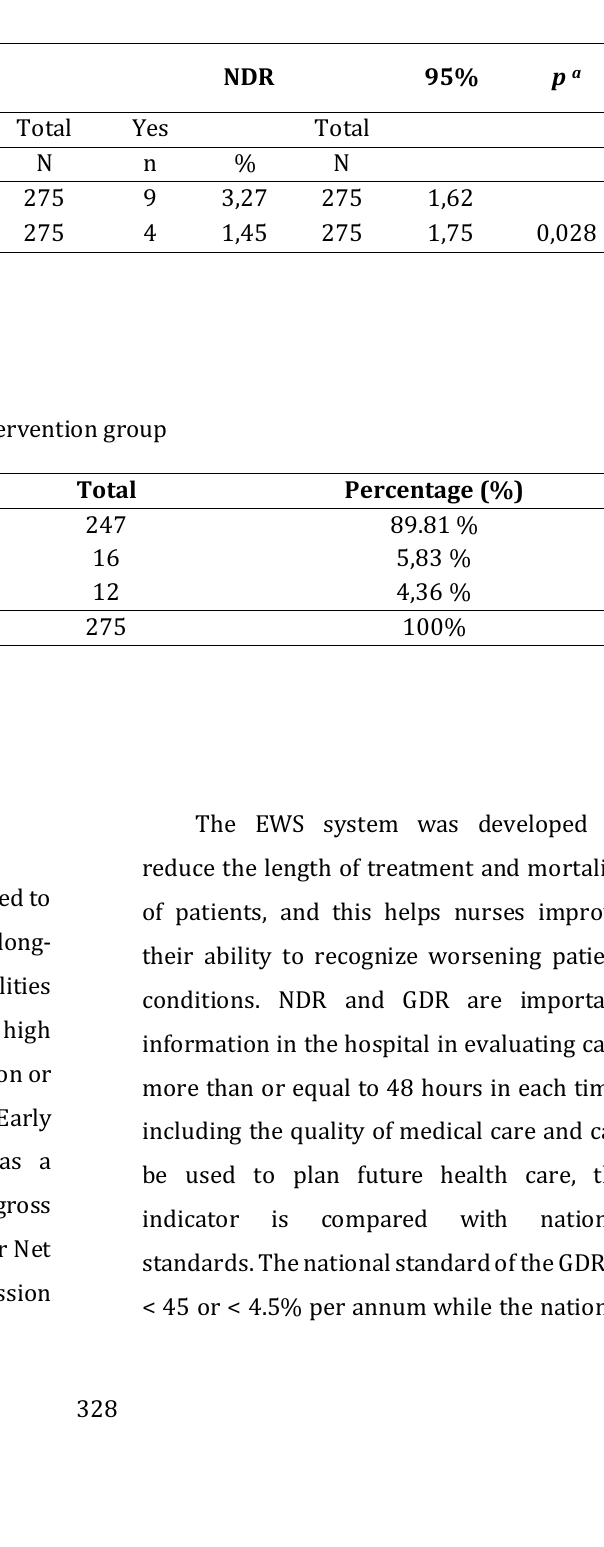
Gross Death Rate (GDR) and Net Death Rate (NDR) after the implementation of Early Warning Score (EWS)